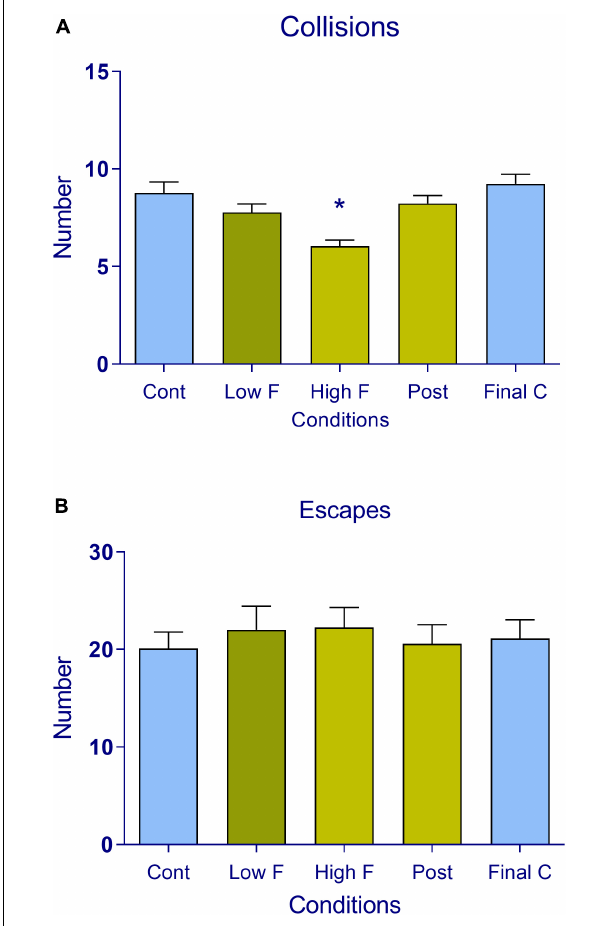
FIGURE 2 | Number of (A) collisions (encounters) of the prey/predator and (B) escape responses recorded in subjects during the five phases of the virtual reality task (control, low fear, high fear, post-encounter, and final control). The data are expressed as mean + SEM. n = 22 across the five conditions (control, low fear, high fear, post-encounter, and final control). * p < 0.05, compared with control.